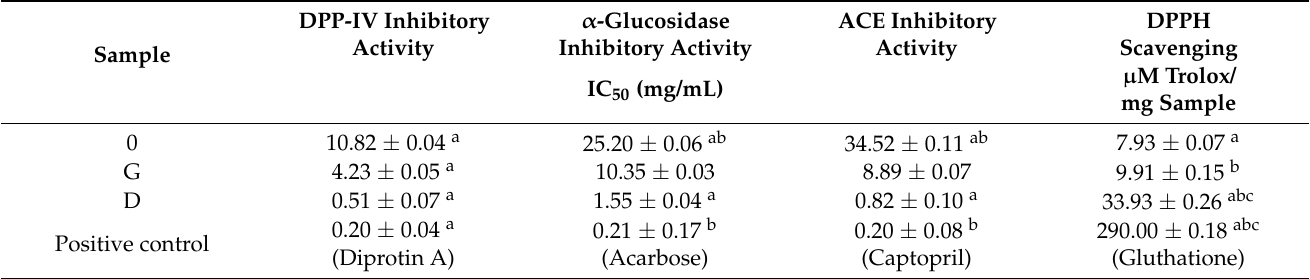
Table 1. Bioactivity of digested oat kernel proteins expressed as half maximal inhibitory concentration (IC 50 ), where 0—intact sample, G—sample after 2 h gastric phase, D—sample after 2 h duodenal phase (see Section 3). Value means ± SD of three determinations. The same superscripts ( a, b, c ) in the same column indicate significant differences between samples ( p <